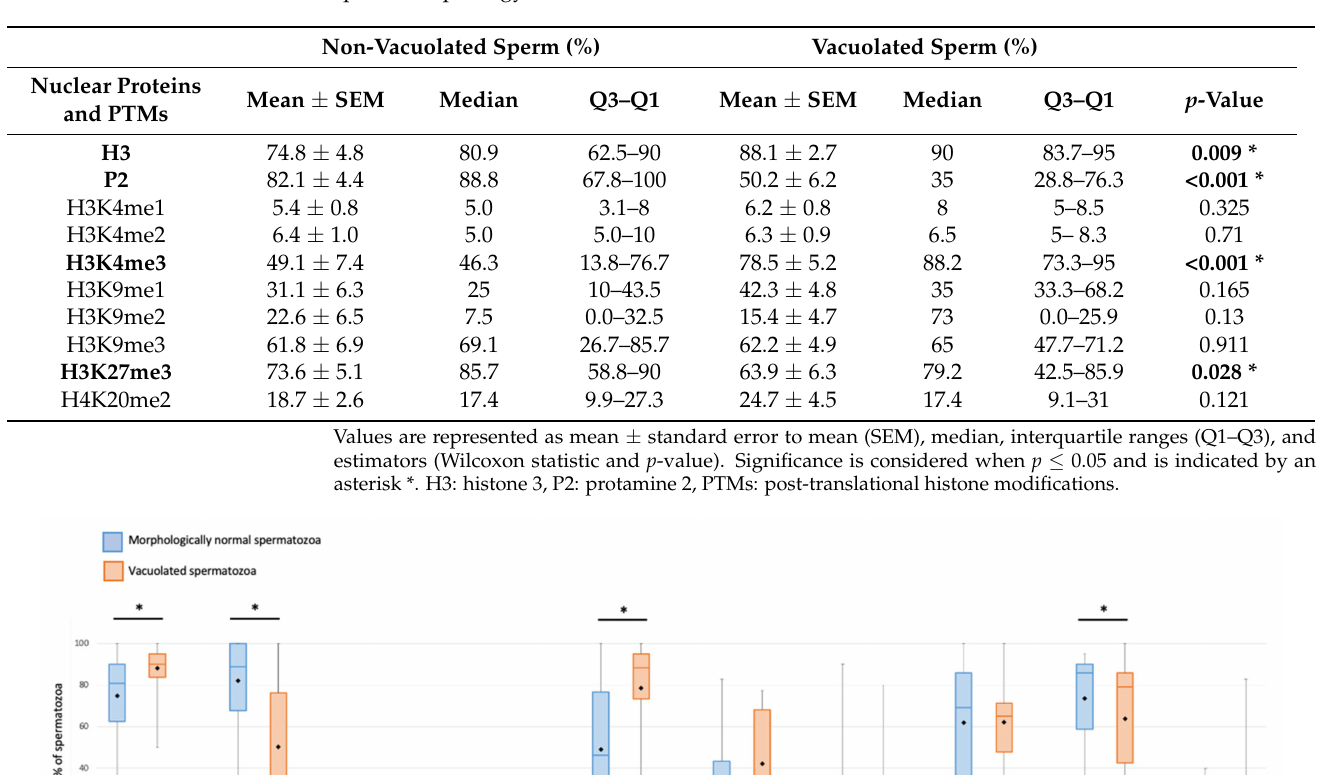
Table 4. Mean and median values of H3, P2, and PTMs observed in the 20 patients according to sperm morphology.